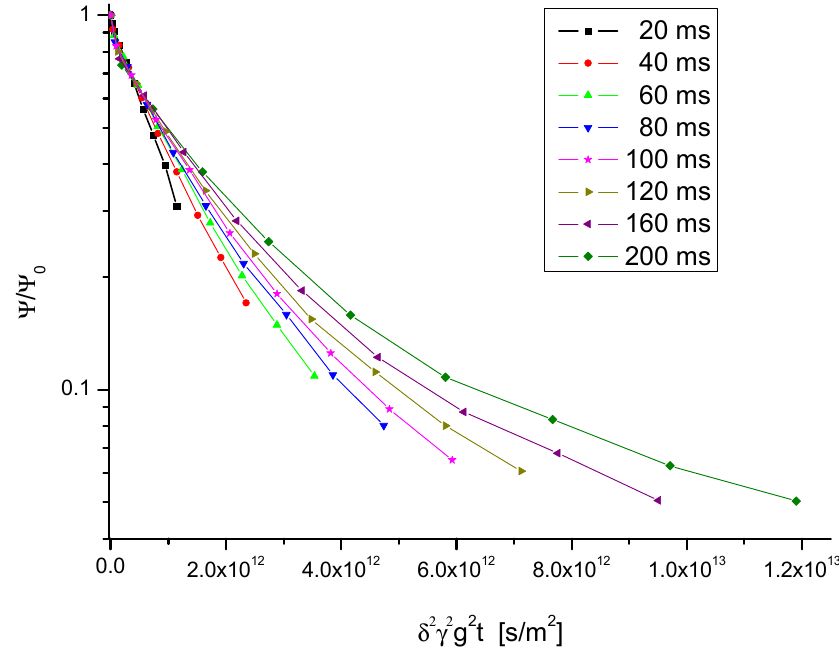
Figure 3. PFG NMR attenuation curves of propane in zeolite NaCa-LTA-0 at a temperature of 25 °C for different observation times.